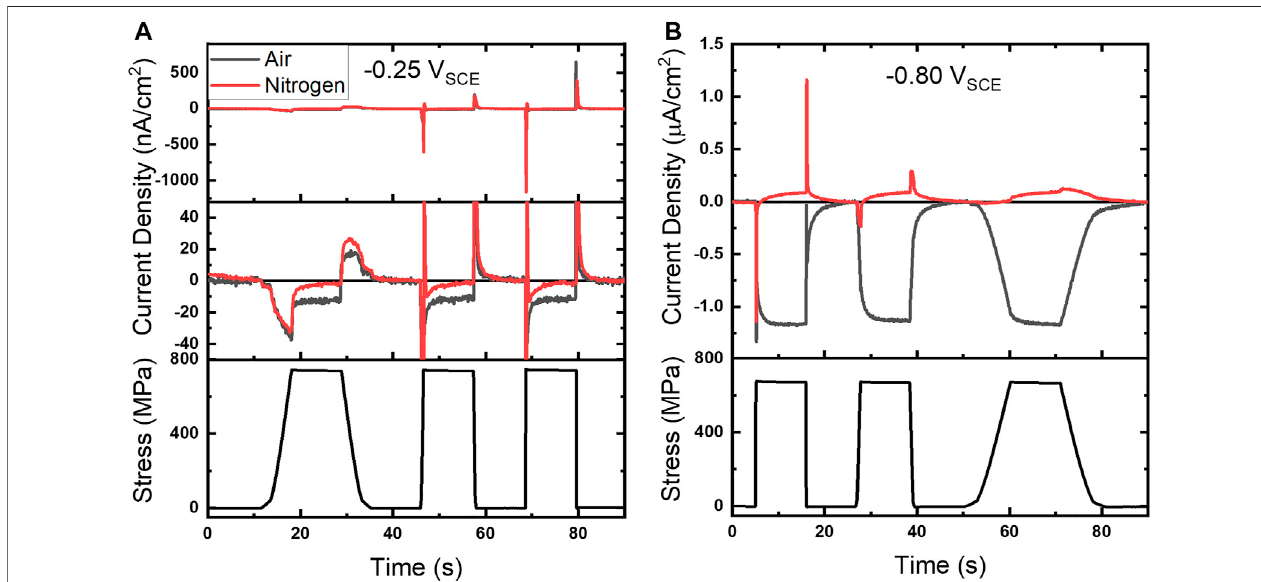
FIGURE5|(A) Baseline subtracted chronoamperogramsunder 25 µlof4.6 MNaCl inairand nitrogen atmospheresalongwithcorrespondingstresspro fi le at (A) − 0.25 V − 0.80 V fi ner scale chronoamperogram is shown in the middle plot of (A) SCE and (B) SCE . A